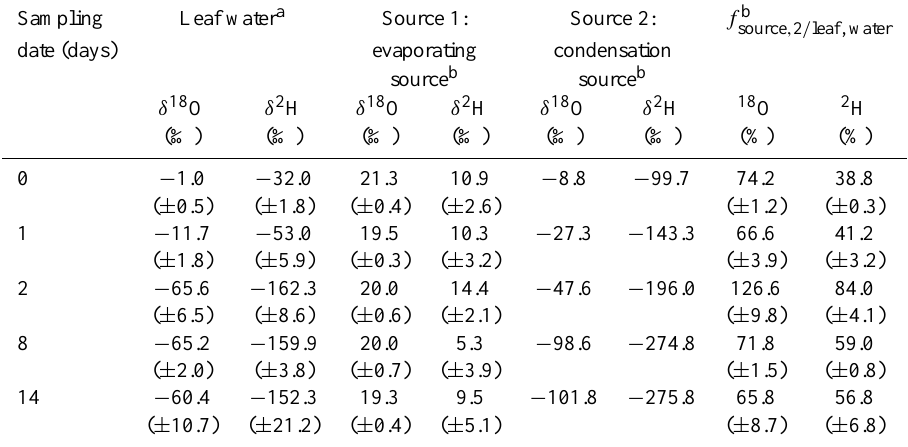
Table 1. Diffusion of atmospheric water vapour into the leaf water. δ 18 O and δ 2 H signatures of leaf water and its two sources: (i) the evaporating source (Eq. 3), estimated by the stem water signature plus kinetic and equilibrium leaf water enrichment (assuming full evapora- tion without back-diffusion), and (ii) the condensation source (Eq. 4), assessed by the atmospheric water vapour signature plus equilibrium fractionation to account for the gas–liquid phase change. The contribution of the second source (diffusion and condensation of atmospheric water vapour) to the leaf water ( f source , 2 / leaf, water ) was estimated by a two-source isotope mixing model for 18 O and 2 H separately (Eq. 2). Presented are the average values of three plant replicates for each sampling date ± 1 standard